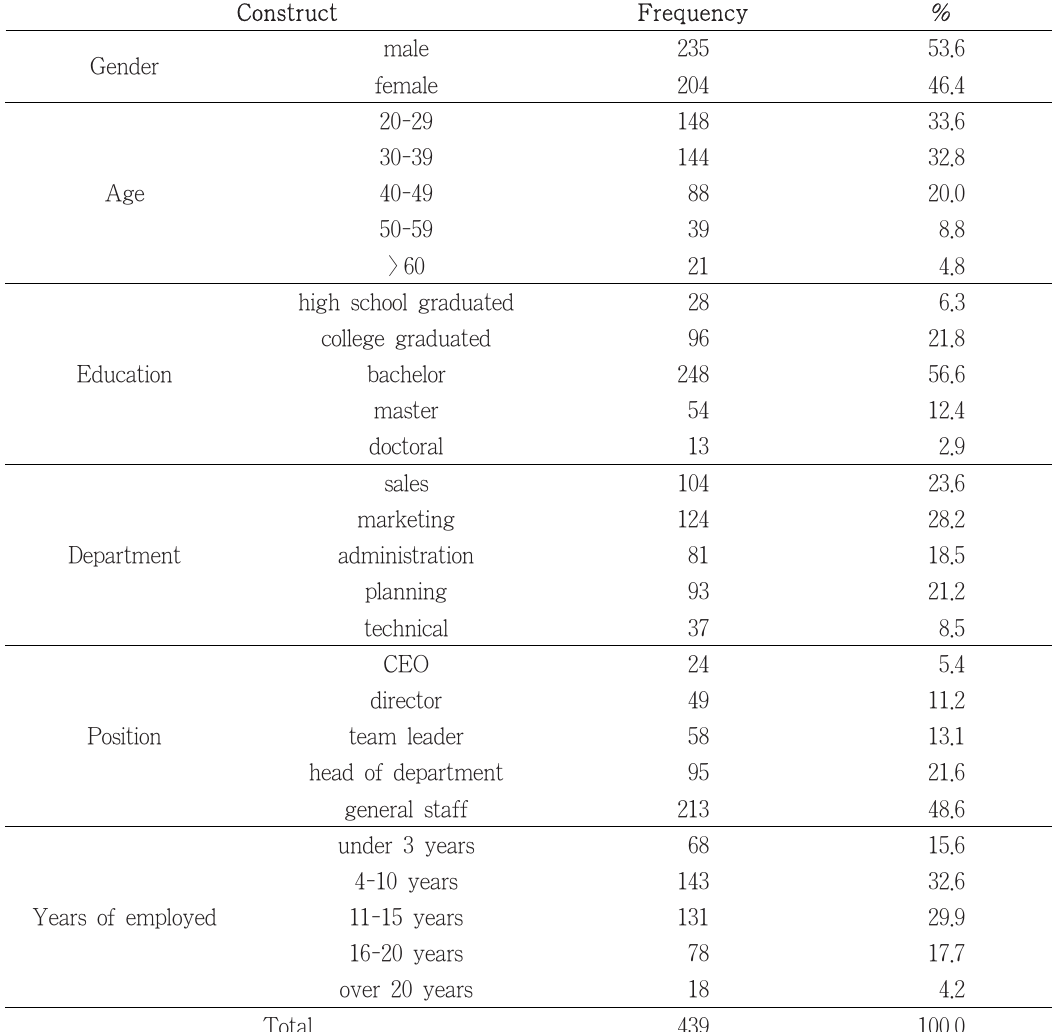
<Table 1> Sample statistics by